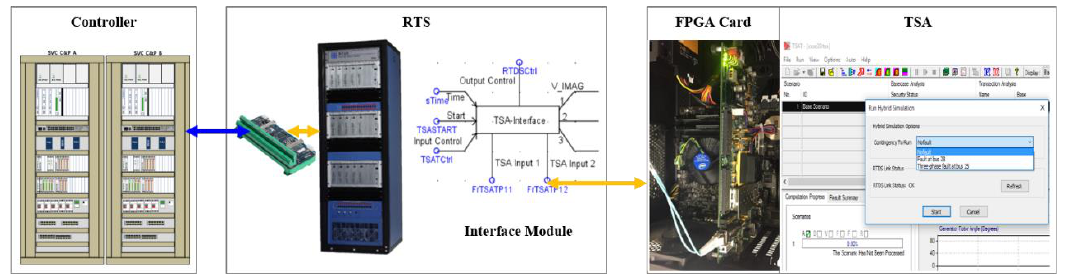
Figure 4. Configuration of real-time hybrid simulator (RTHS).